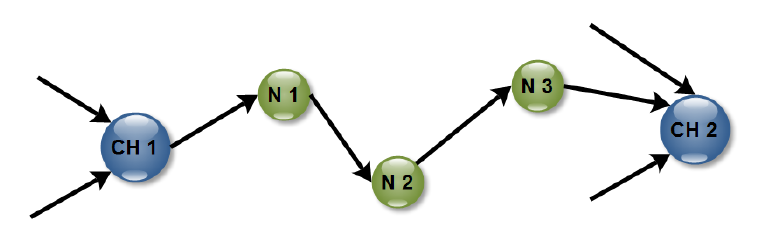
Figure 6. Example of a transmission from Cluster Head CH 1 to Cluster Head CH 2